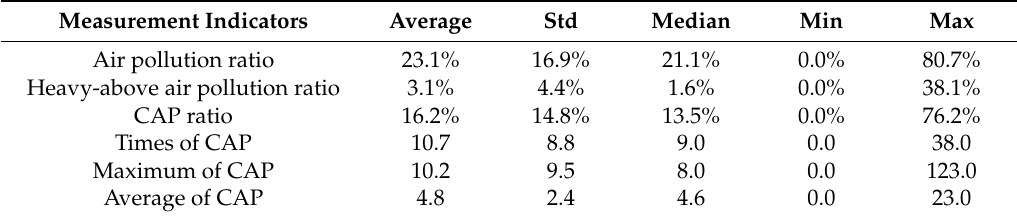
Table 2. Descriptive statistics of air pollution in